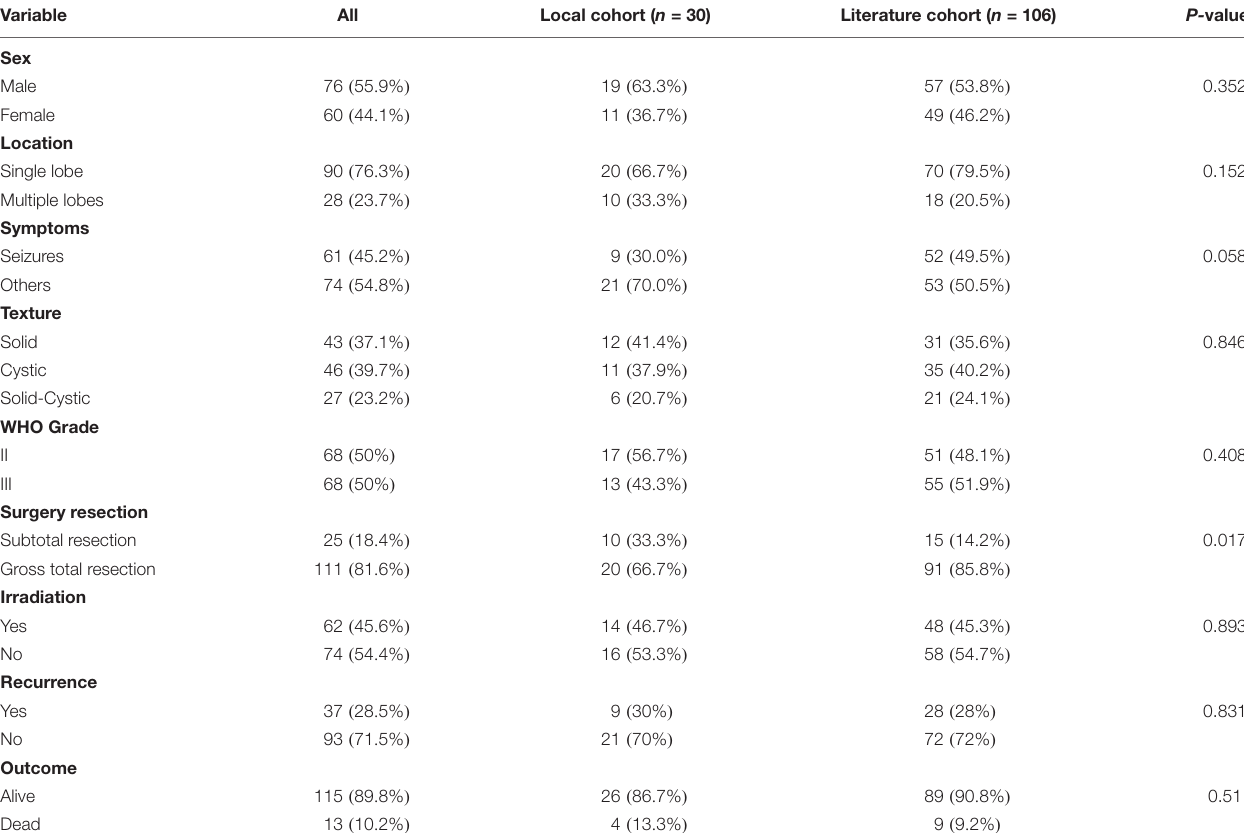
TABLE 3 | Baseline characteristics of CEs, and a comparison between literature and local cohorts.